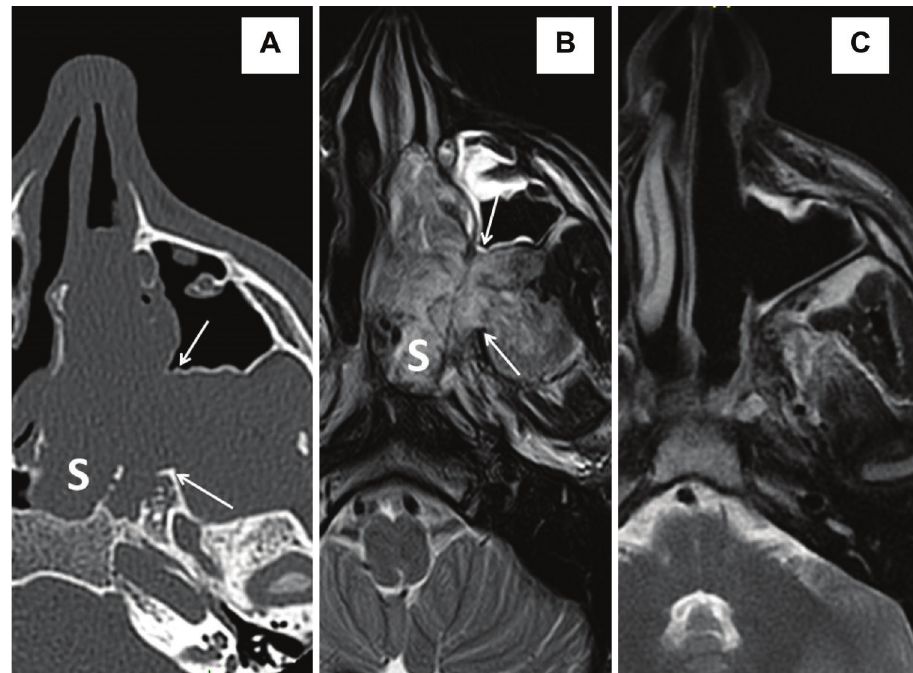
Figure 2 - Juvenile nasopharyngeal angiofibroma, case P5, Radkowski grade 2c. Axial CT (A) and MRI T2-weighted scans (B) showing a mass in the dorsal two thirds of the left nasal cavity and in the sphenoid sinus (marked by S) with a bulky extension to the pterygopalatine fossa and the ITF. Extensive anteroposterior widening of the sphenopalatine foramen is marked by arrows . (C) An axial MRI T2-weighted scan one year after surgery demonstrating no evidence of